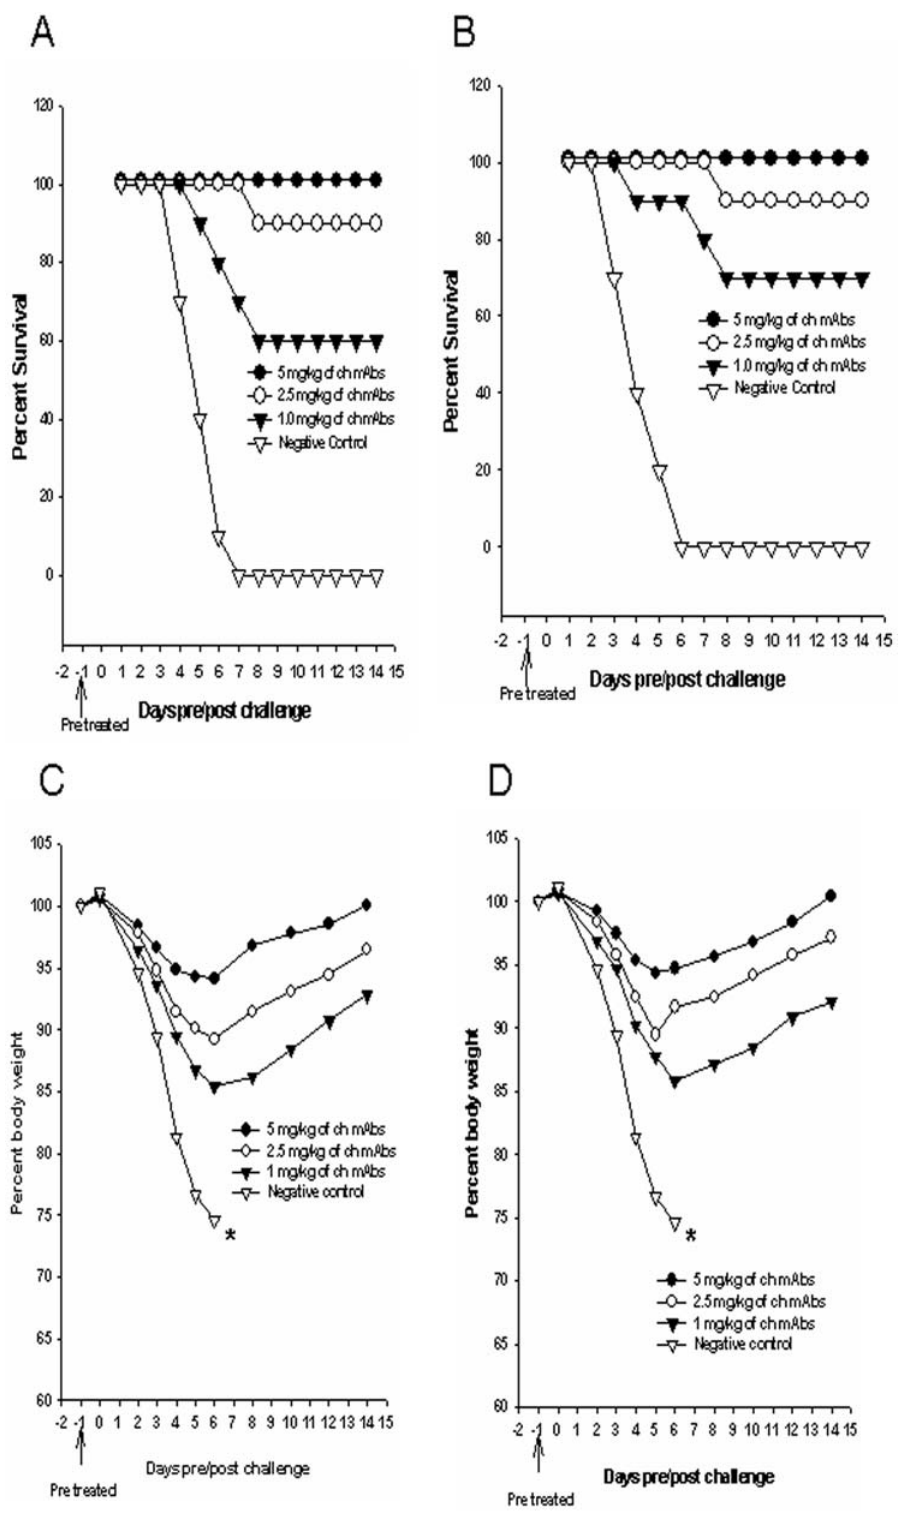
Figure 1. Prophylactic efficacy of the combination of chimeric mAbs in mice. Groups of mice (n=10) were pre-treated intraperitoneally with 1 mg/kg, 2.5 mg/kg, 5 mg/kg or 0 mg/kg (PBS) of the combination of ch-mAbs, one day before challenge with 10MLD 50 of mouse-adapted HPAI H5N1 from A/Vietnam/1203/2004 (A and C) or clade 2.1 virus A/TLL013/06 (B and D). An irrelevant IgG1 monoclonal antibody (specific for porcine circovirus) was used as a negative control. Mice were monitored for survival (A and B) and weight loss (C and D) throughout a 14 day observation period. The results are expressed in terms of percent survival and percent body weight (at the beginning of the trial) respectively.